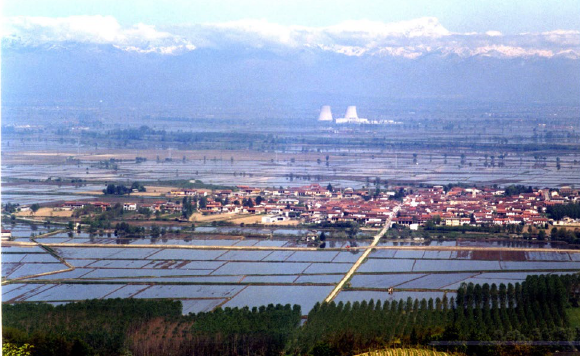
Figure 2. Scenic bird’s eye view of the agricultural landscape during the period of flooding of paddy-rice